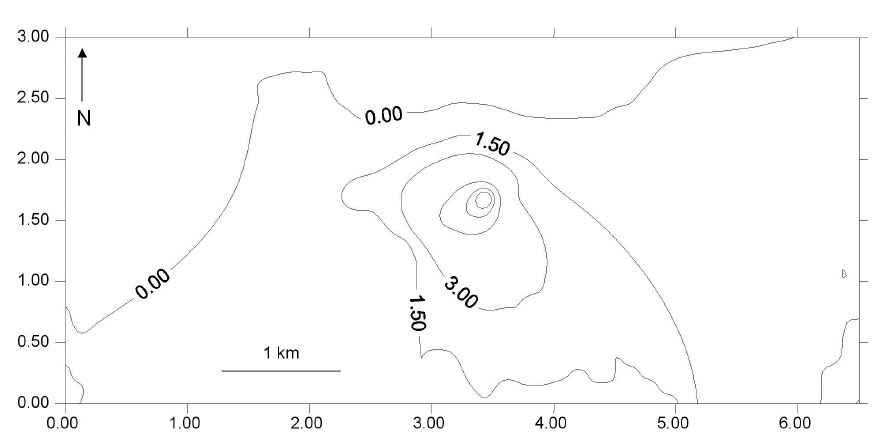
Fig. 2 Dust-like emissions of airborne particles in the region of sampling.